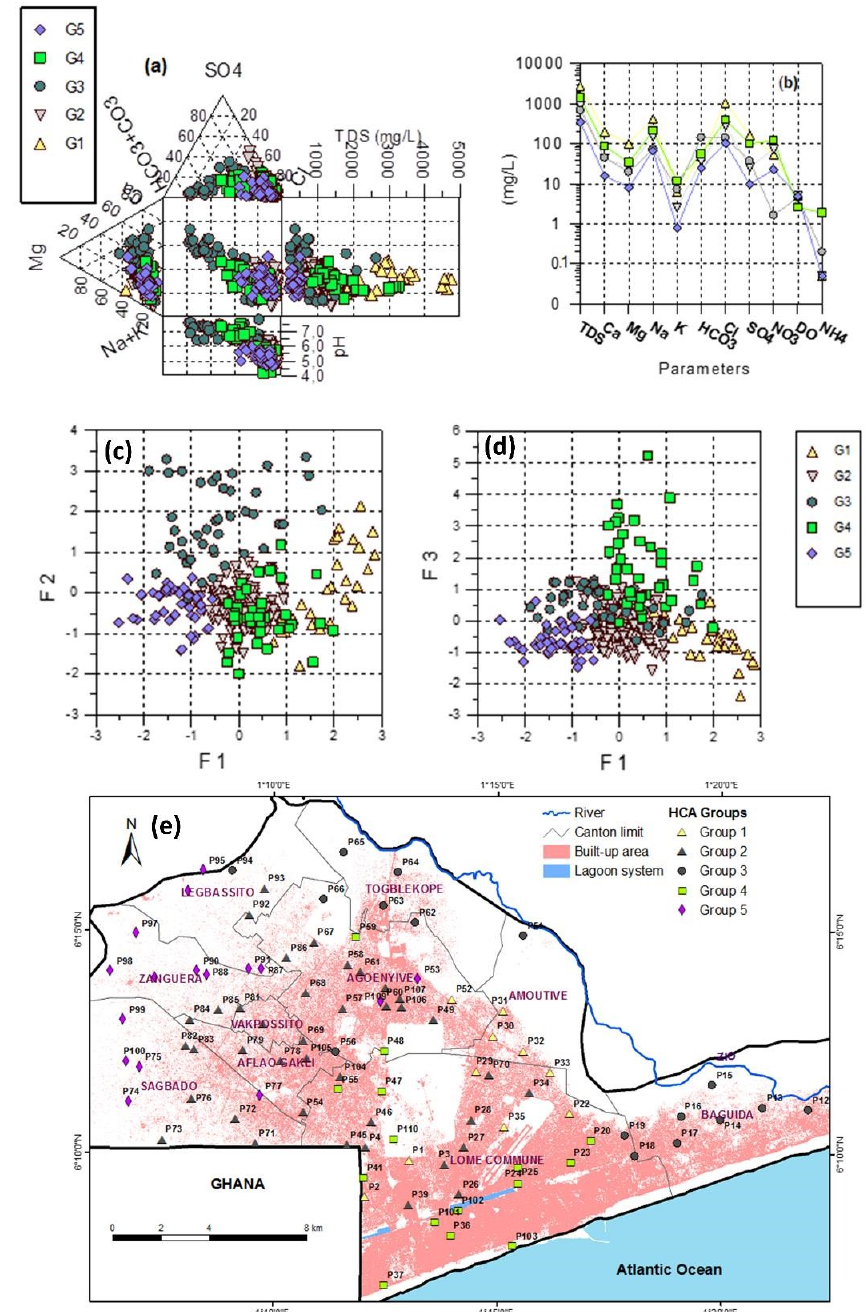
Figure 2. (a) Durov diagram of samples and (b) Schoeller diagram of the median chemical composition of each CHA group (b, c) Factorial scores for samples, (e) Spatial distribution of groups of samples. The built-up area is extracted from a SPOT-6 2015-12-08 satellite image (Copyright © AIRBUS Defence &